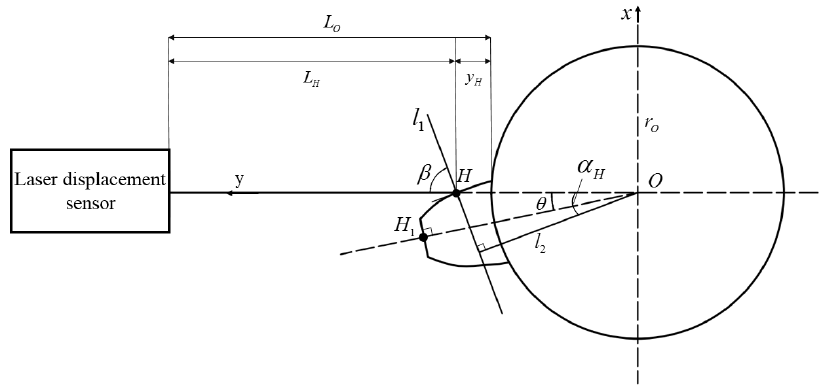
Figure 3. Schematic diagram of the error compensation and coordinate conversion.